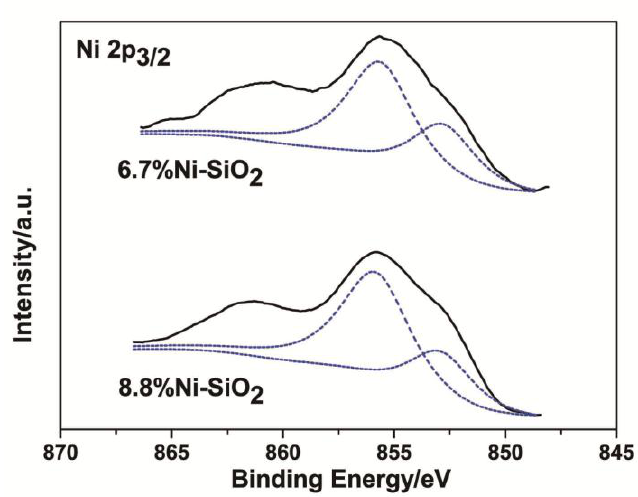
for the reduced 6.7%Ni-SiO 3/2